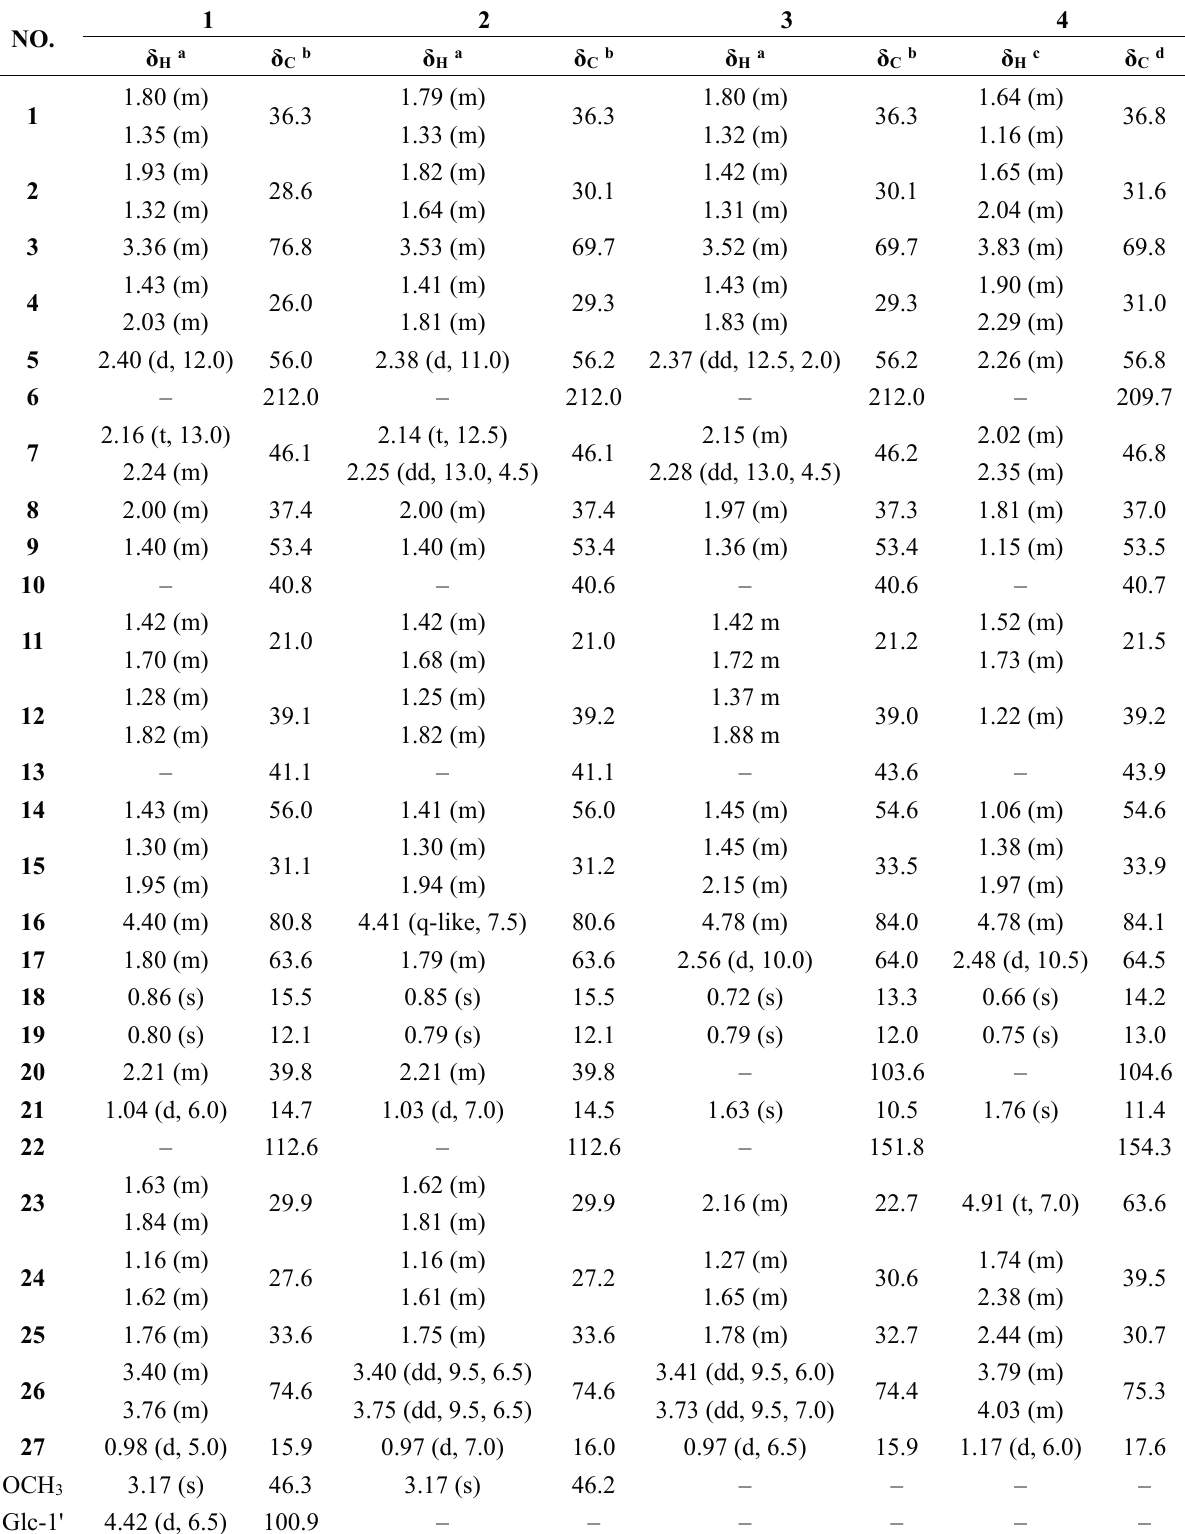
Table 1; ESI-MS: m/z 941.4 [M+Na] + and 917.3 [M − H] − ; HR-ESI-MS: m/z 941.4727 [M+Na] + (Calcd for C 45 H 74 NaO 19 : 941.4717). Table 1. 1 H- and 13 C-NMR Data of Compounds 1 – 4 . ( δ in ppm, J in Hz).